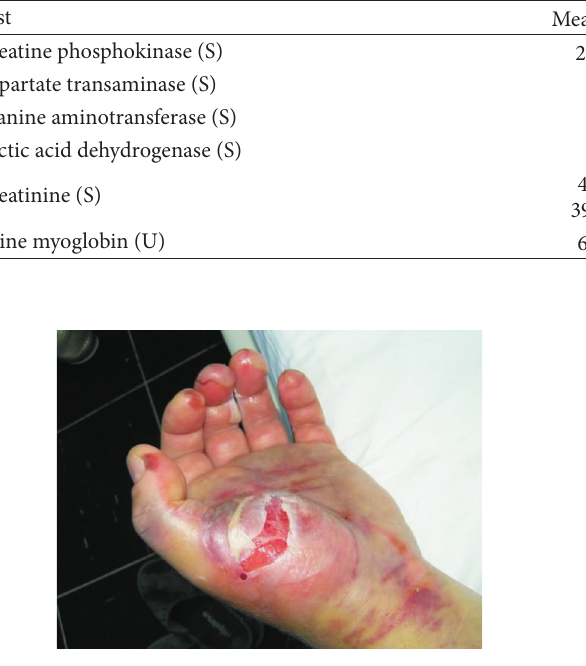
Figure 2: Large bruise and edema of the right arm and forearm.